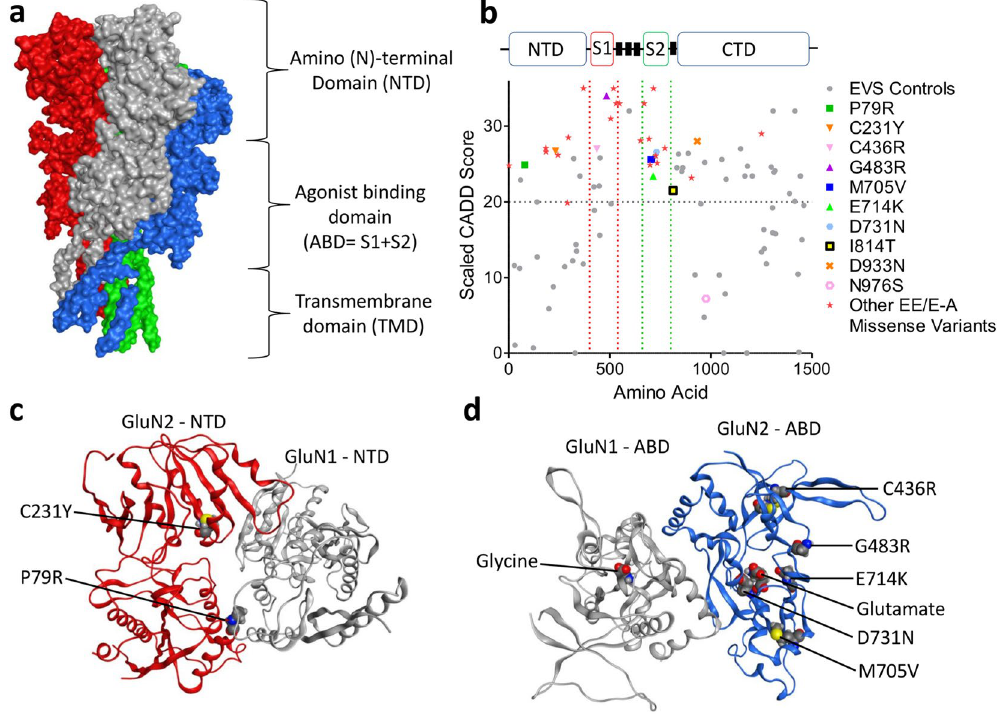
Figure 1. CADD scores and protein modelling predict stronger functional effects for EAS-associated GRIN2A mutations than in controls. ( a ) Protein structure model of NMDAR (PDB ID 4TLL): GluN1 (grey and green), GluN2 (B in this structure) (blue and red). Membrane would be horizontal in this image with the NTD and ABD in the extracellular space. Intracellular C-Terminal domain would be below the transmembrane domain (not present in this structure). ( b ) Schematic linear representation of GluN2A with the domains annotated. Black rectangles indicate transmembrane domains. Plot of scaled CADD scores against GluN2A amino acid position for missense variants. Black dots represent scores for 65/6474 individuals from the Exome Variant Server (EVS) that had missense variants in GRIN2A and coloured symbols are scores for variants found in individuals with EAS disorders. The horizontal dotted line indicates the scaled CADD score cut off of 20 for a highly likely deleterious variant. ( c ) Protein structure model of the NTD of NMDAR (PDB ID 3QEL): GluN1 (grey), GluN2 (B in this structure) (red). Mutations considered in this domain highlighted (conserved between GluN2A and B). ( d ) Protein structure model of the LBD of NMDAR (PDB ID 2A5T): GluN1 (grey), GluN2A (blue). Mutations considered in this paper highlighted, as well as agonists.